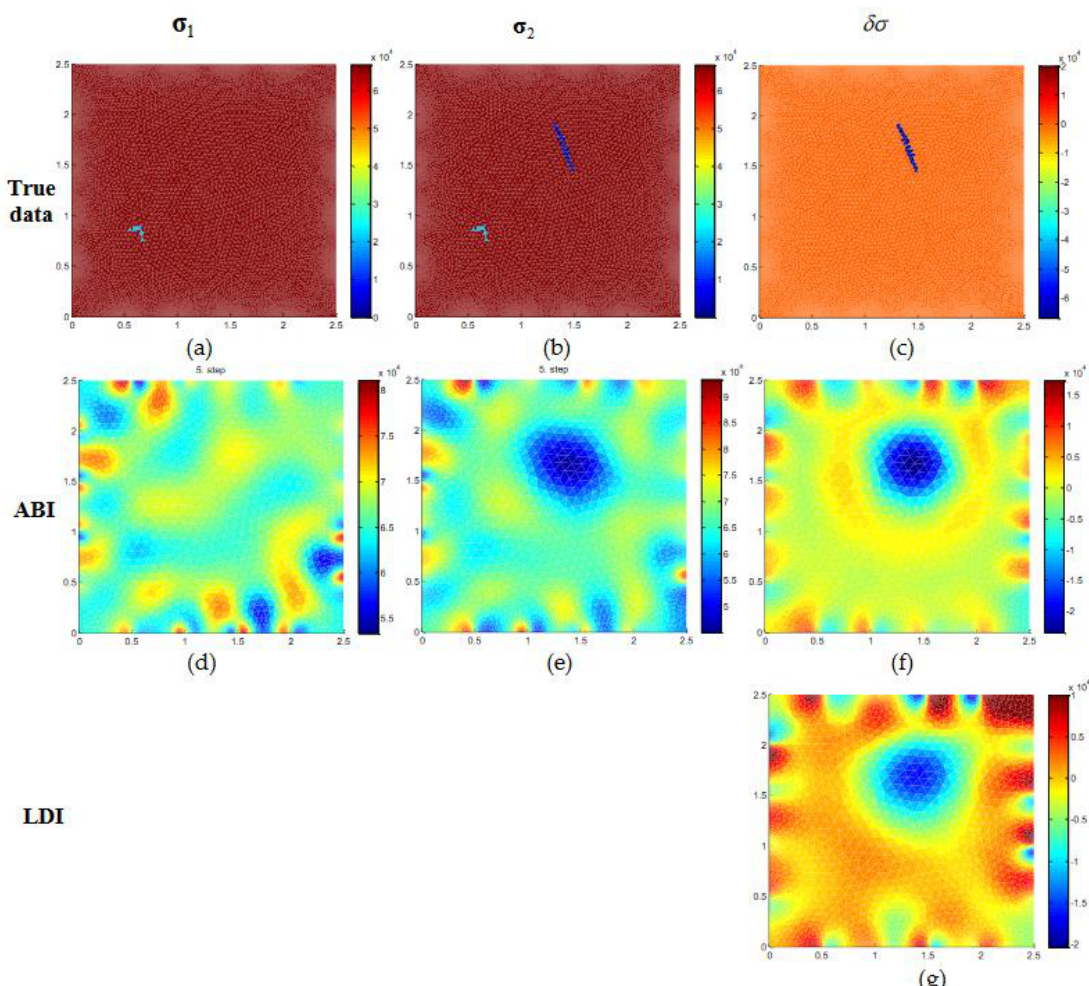
Figure 4. Numerical simulation of graphene conductivity estimation for test case 2 with 0.5% relative noise. ( a – c ) The top row is the true conductivity distribution while the second row ( d – f ), third row ( g ) are estimated conductivities of initial distribution ( σ 1 ) , final distribution ( σ 2 ) , and conductivity change ( δσ ) using ABI and LDI.